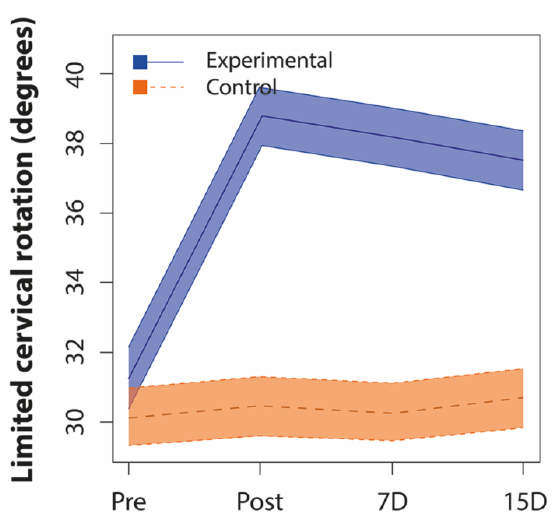
Figure 3. Differences with 95% confidence interval in behavior during intra-subject follow-up of limited cervical rotation between both groups. Pre: Pre-intervention baseline data; Post: Post-immediate data; 7D: Data on the 7th day; 15D: Data on the 15th day. Table 3. Interaction between factors (time * group) showing the differences by group at each evaluation (post hoc Sidak test).